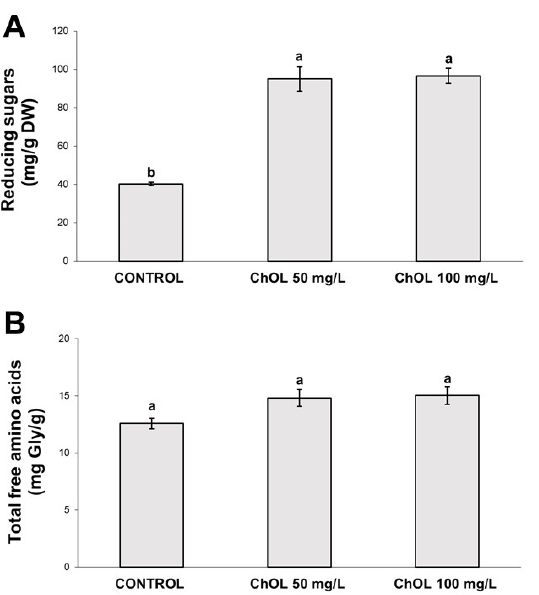
Figure 3. Effects of chitosan oligosaccharide lactate (ChOL) on reducing sugars ( A ) and total free amino acids ( B ) content in leaves of red perilla. Bars represent the average and error bars show standard errors of the mean. Different letters above and below bars indicate significant differences at p ≤ 0.05.